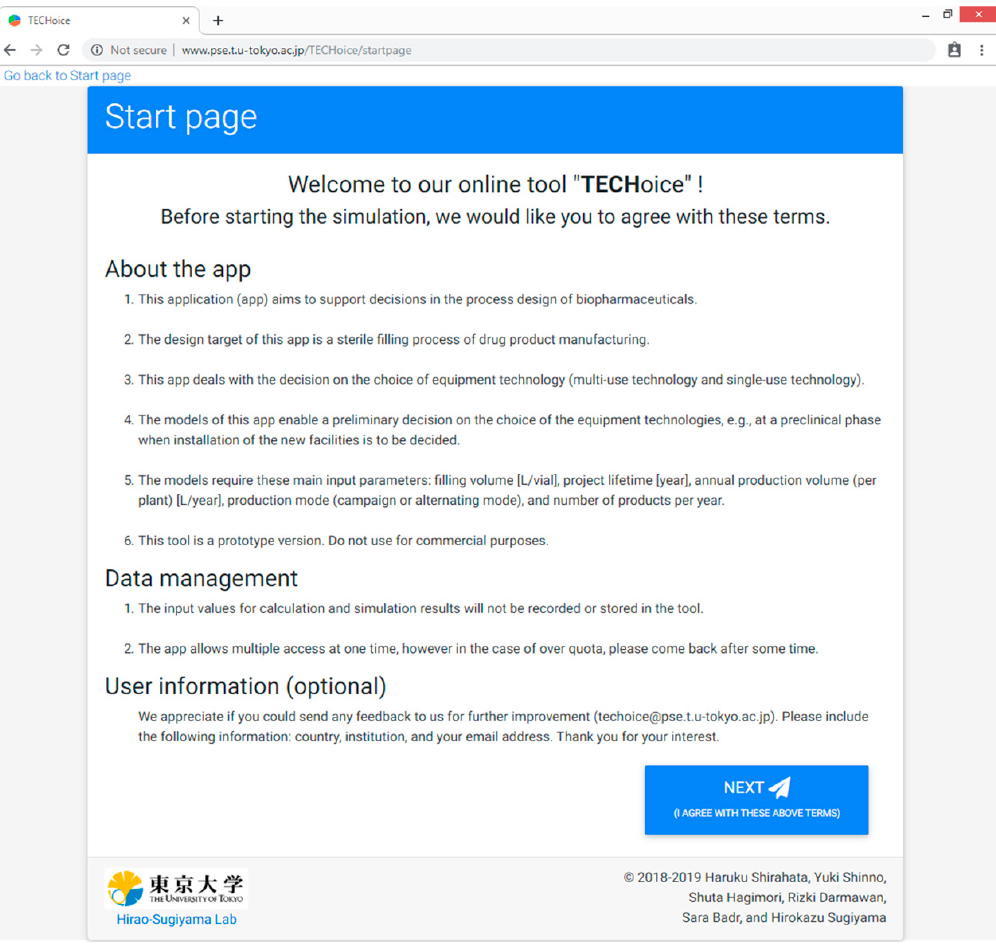
Figure A1. Screenshot of the first page (Start page) of “ TECH oice”.